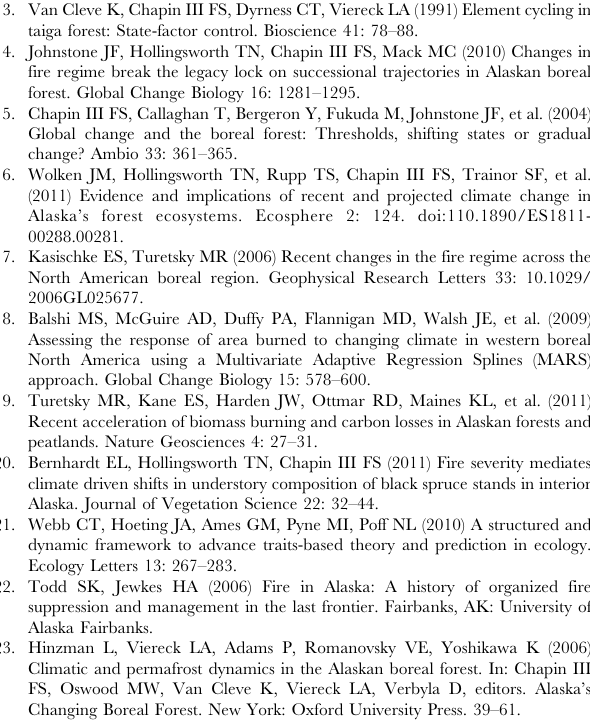
Table S1 Site/Trait Matrix (S 6 T) derived by multiply- ing Species/Site matrix (A 6 S and Species/Trait matrix traits summed to 1. A 6 T was derived by multiplying the